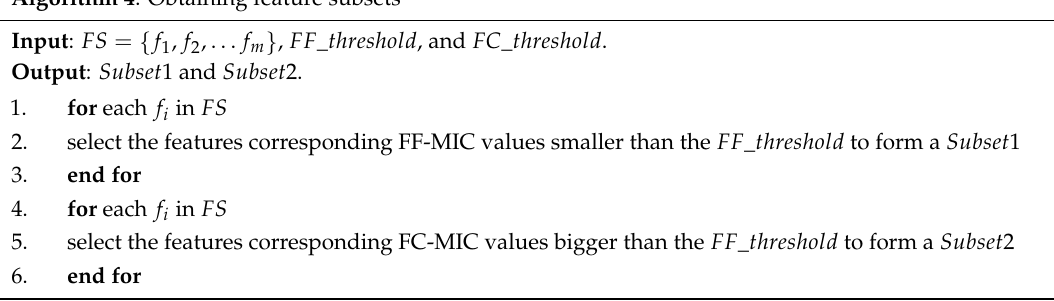
Algorithm 4 . Obtaining feature